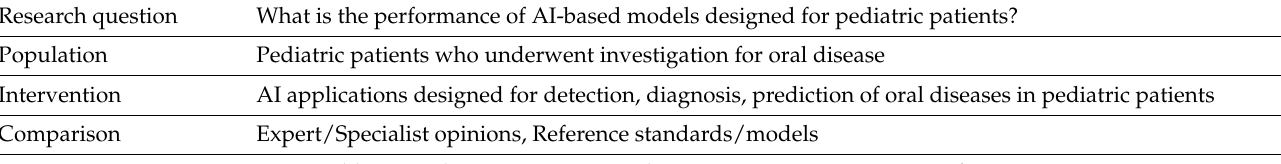
Table 1. DescriptionofthePICO(P=Population, I=Intervention, C=Comparison, O=Outcome)elements. Research